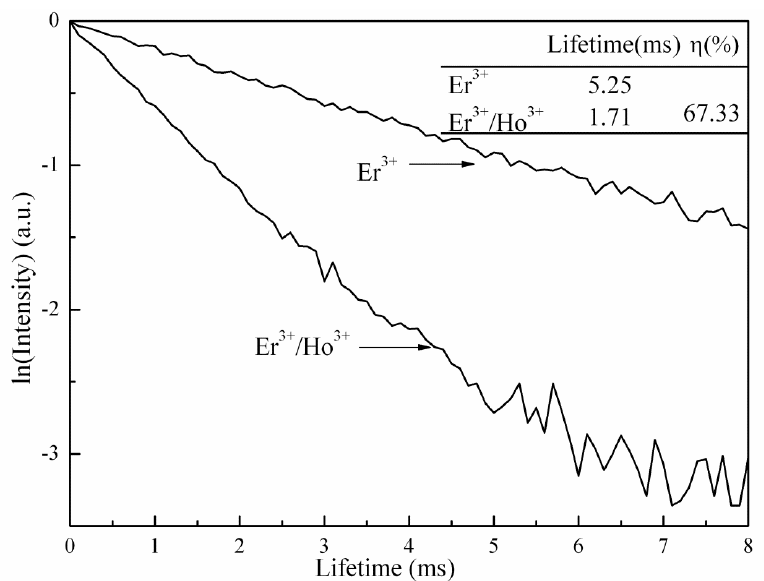
Figure 5. Fluorescence decay curves of Er 3+ : 4 I codoped